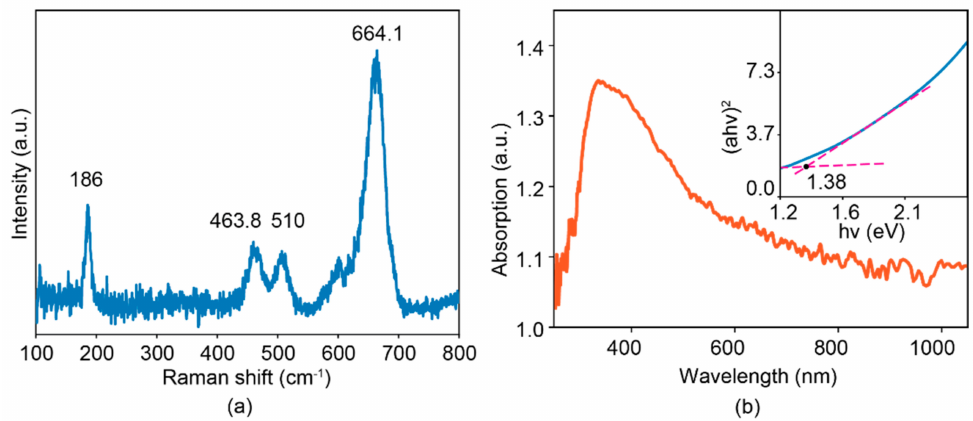
Figure 4. Raman spectrum ( a ). UV-Vis-NIR absorption spectra ( b ) with the corresponding Tauc-plot in the